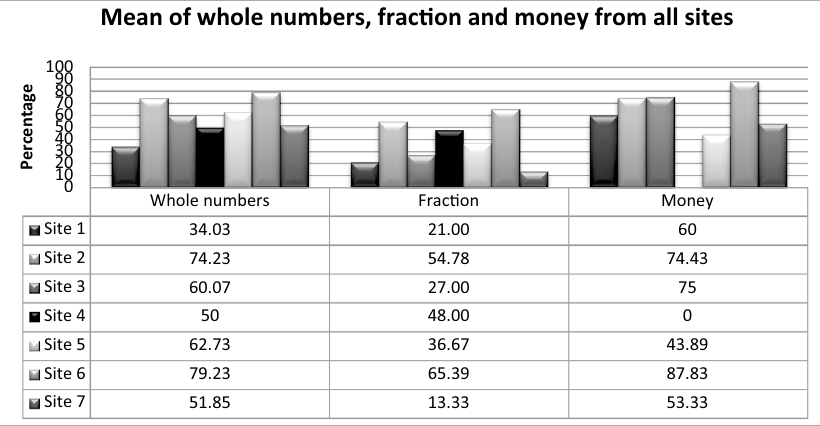
Whole numbers Frac(cid:31)on Money